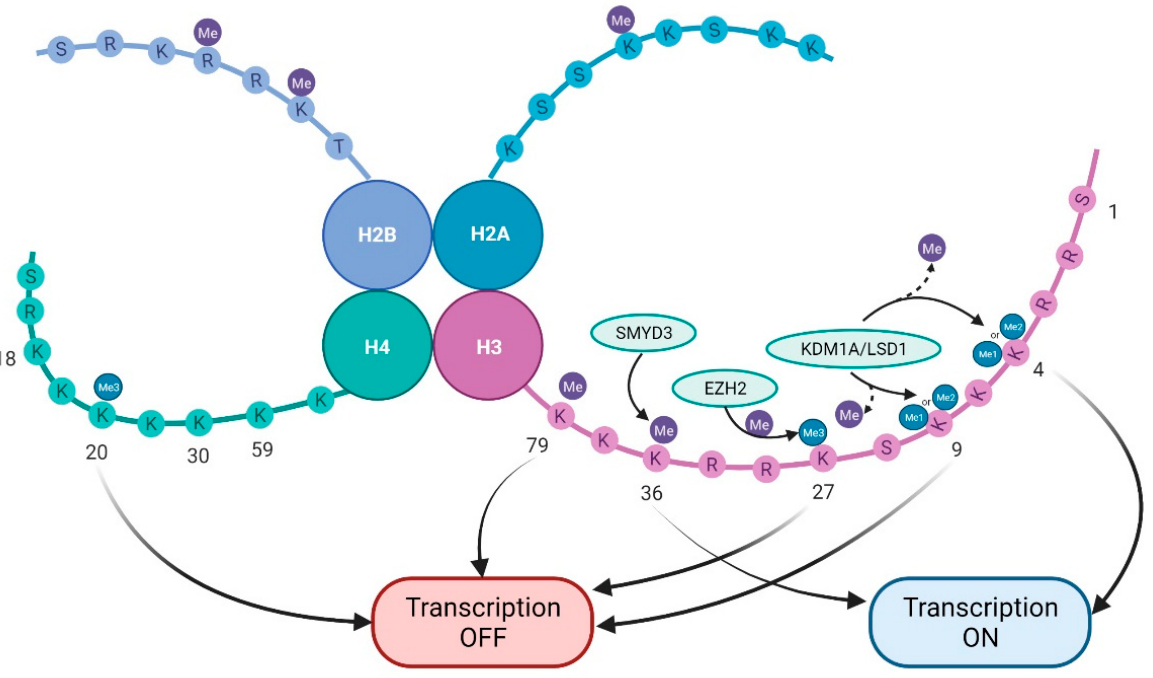
Figure 2. Histone methylation landscape in lung cancer. The lysines K4, K9, K27, K36, and K79 on histone H3 and K20 of histone H4 are amenable for modification by methylation. While H3K4 and H3K36 methylation activate gene transcription, H3K9, H3K27, H3K79, and H4K20 methylation suppress gene transcription. Histone lysine methyltransferases (KMTs) add methyl groups to histones and are ‘writers’ of the histone code. SMYD3 targets H3K36, and EZH2 mediates trivalent methylation of H3K27, causing chromatin condensation and subsequent repression of TSG transcription. On the other hand, demethylases, such as KDMs, are known as ‘erasers’ of methyl groups, and consequently, KDM1A/LSD1 targets H3K4me2/me1 and H3K9me2/me1.